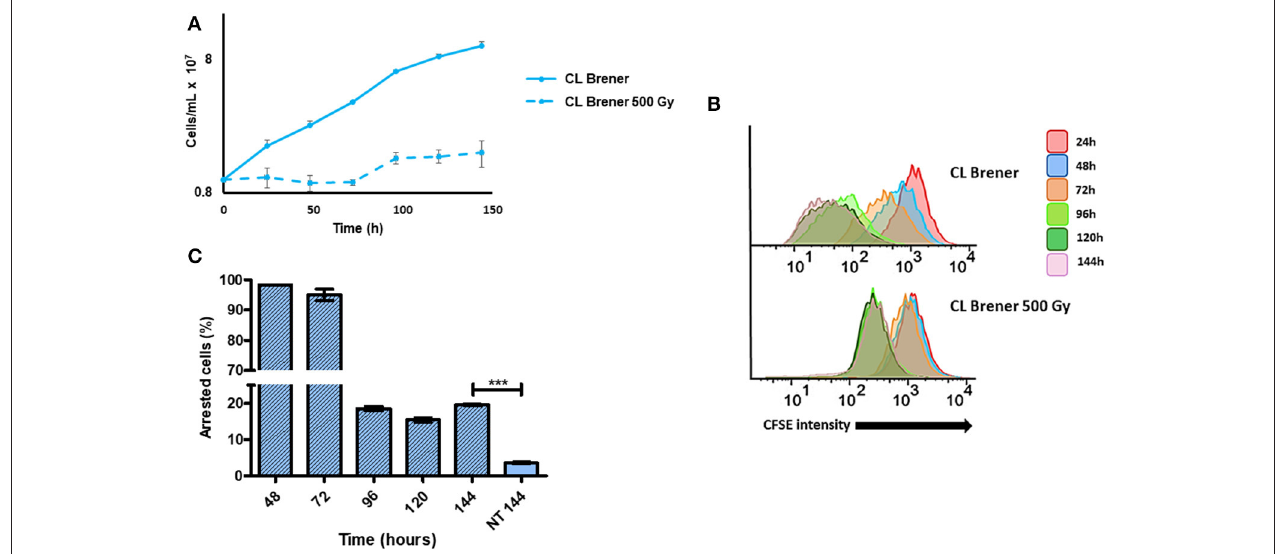
FIGURE 5 | Dormancy in epimastigotes from CL Brener strain after gamma radiation exposure. (A) A 144 h-growth curve of wild-type T. cruzi CL Brener strain exposed or not to 500Gy of gamma irradiation. (B) Flow cytometry histograms of CFSE fluorescence intensity decay over time from epimastigotes exposed or not to 500Gy. Cells that have similar CFSE fluorescence intensity compared to the level of half median of 24h time point were considered as arrested. (C) The graph shows the percentage of arrested parasites determined by flow cytometry showing half of CFSE median intensity observed at 24h of growth. The percentage of dormant parasites at 144 h- from a culture without exposure to gamma radiation (NT 144h) is shown for the sake of comparison. Representative results of three distinct experiments are shown. Asterisks indicate statistically significant differences among groups ( P -value < 0.05).